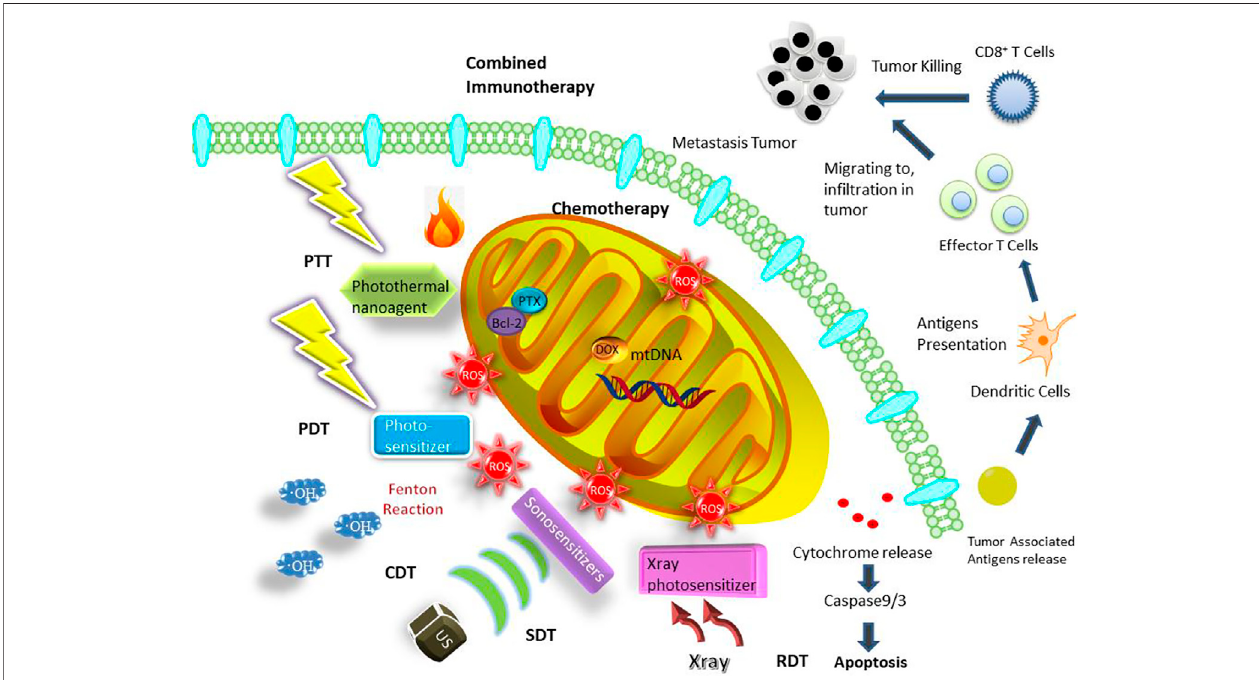
FIGURE 1 | Mitochondria-targeted cancer therapies enabling by nanoplatforms including chemotherapy, PTT, PDT, CDT, SDT, RDT and combined immunotherapy.